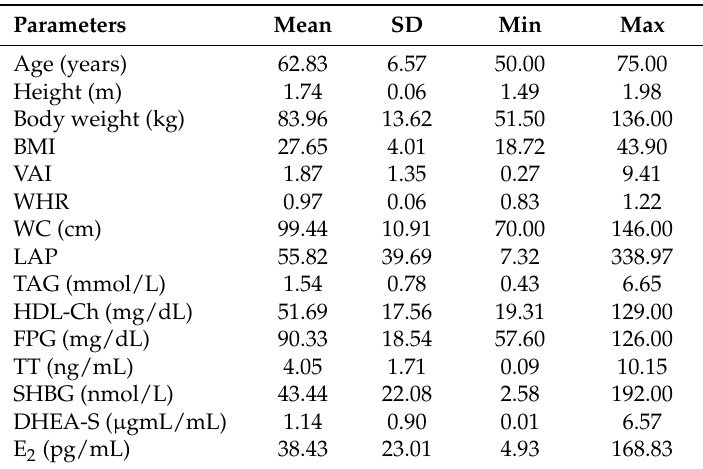
Table 1. Characteristics of the study group ( n =